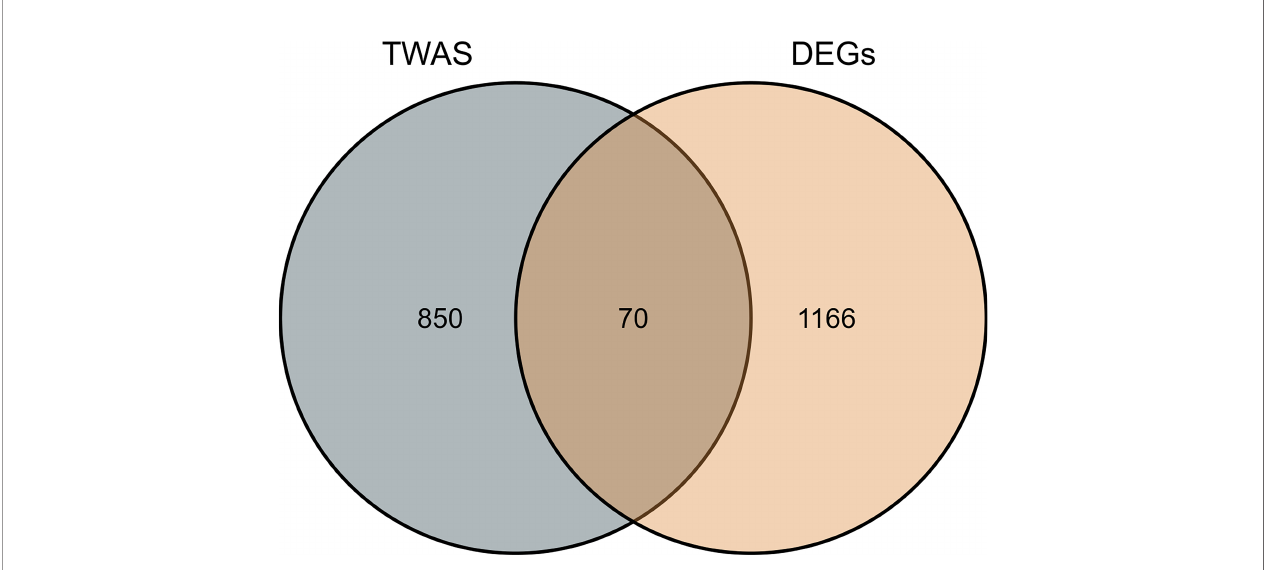
FIGURE 3 | Venn diagram of TWAS versus common genes identi fi ed by mRNA expression pro fi ling. Gray, TWAS; Orange,